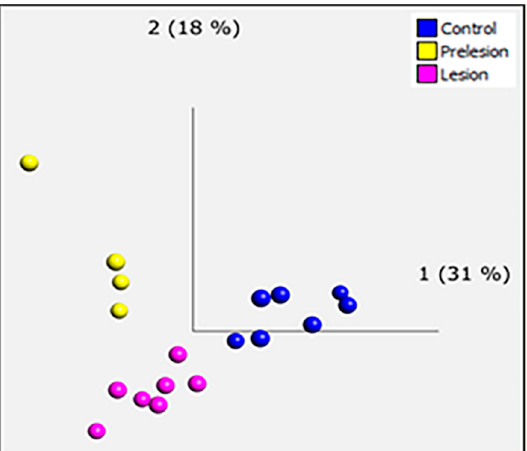
Figure 2. Principle component analysis (PCA) of ageing periventricular transcriptomic datasets. The PCA plot of control (blue), “pre-lesion” (yellow) and PVL (pink) shows a separation of differentially-expressed genes between the groups.